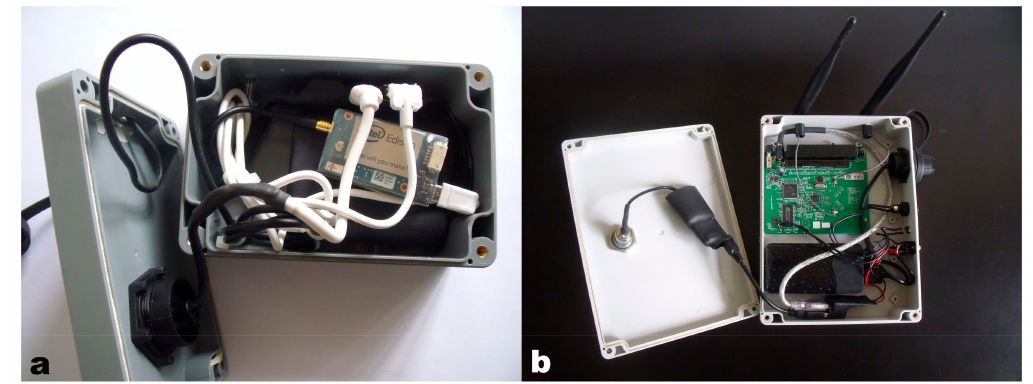
Figure 2. Inner components of the rover ( a ) and of the base station ( b